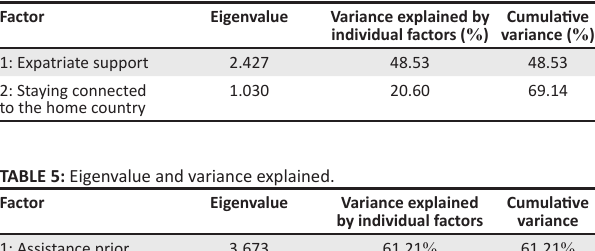
TABLE 4: Eigenvalues and variance explained.